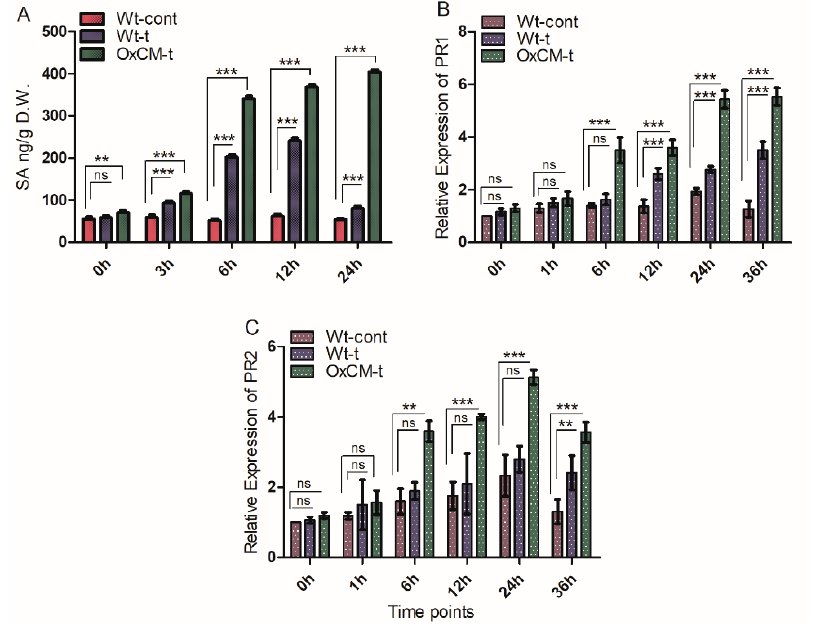
Figure 4. White-backed planthopper (WBPH) induces salicylic acid signaling and pathogenesis-related gene expression. ( A ) SA accumulation after different time points in wildtype control plants (Wt-cont), wild-type plants infected with WBPH (Wt-t), and chorismate mutase transgenic over-expressor plants infected with WBPH (OxCM-t). ( B , C ) Relative expression of PR1 and PR2 genes, respectively, at different timepoints after WBPH infestation. Actin was used as a reference gene. Graph bars indicate the mean ± standard deviation ( n = 3), ns indicates non significant and asterisks indicate significant differences (** p < 0.01, *** p < 0.001) analyzed using two-way analysis of variance and Bonferroni post hoc test. The experiments were repeated three times.